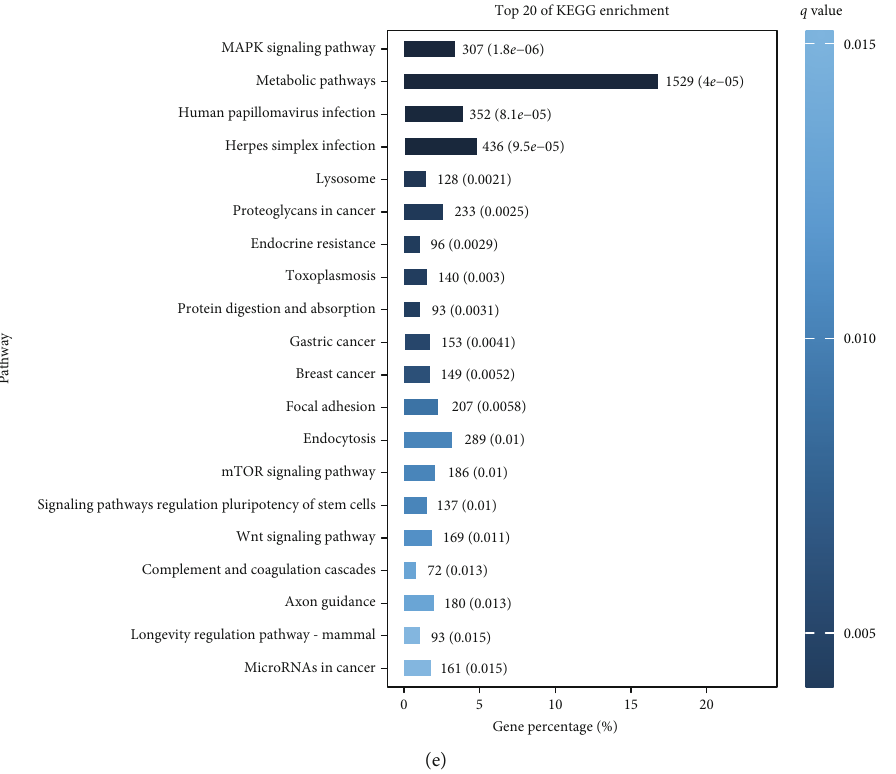
Figure 2: Enrichment of di ff erentially expressed miRNA target genes. (a) All GO enrichment items of target genes. (b) Top 20 GO enrichment s in BP. (c) Top 20 GO enrichment s in CC. (d) Top 20 GO enrichment s in MP. (e) Enrichment pathways of target genes by KEGG pathway enrichment